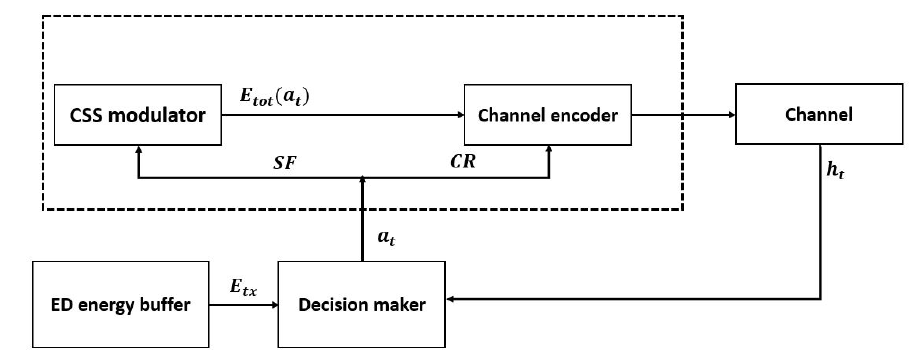
Figure 2. Flowchart of the proposed